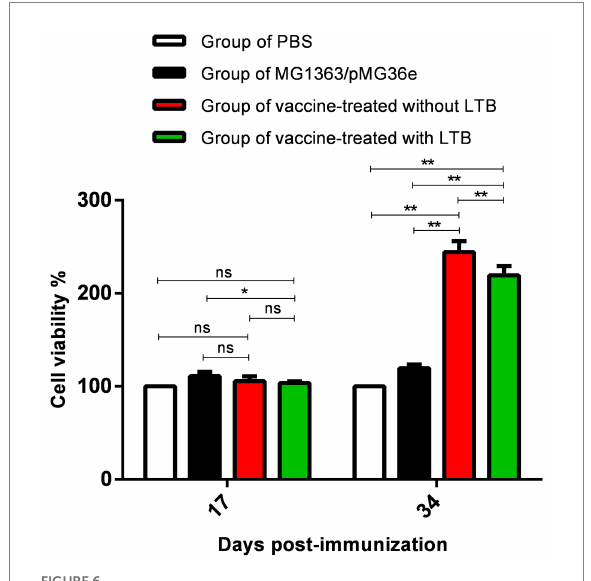
FIGURE 6 The cell viability of splenocytes after the first immunization on 17 and 34 dpv by CCK-8. “**” in the figure means the difference is extremely significant p < 0.01, “*” indicates a significant difference p < 0.05, and “ns” indicates no significant difference p >